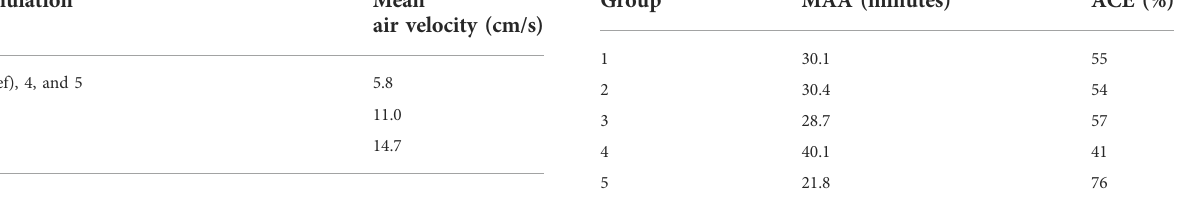
TABLE 4 Air velocity above the water surface: numerical results. Simulation